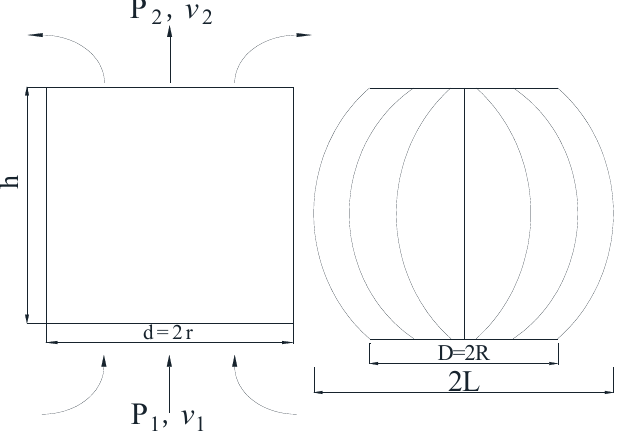
Figure 21. Simplified drawing of a natural ventilator.